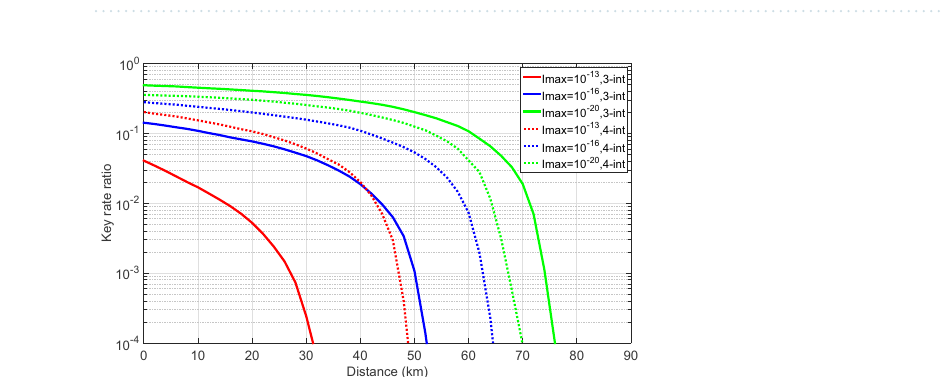
Figure 6. The secret key rate in logarithmic scale as a function of the distance in Case 1 for the four-intensity protocol. ( a ) Here we consider a fixed value of the total number of transmitted pulses, N values for the intensity I max . ( b ) Here we fix I max